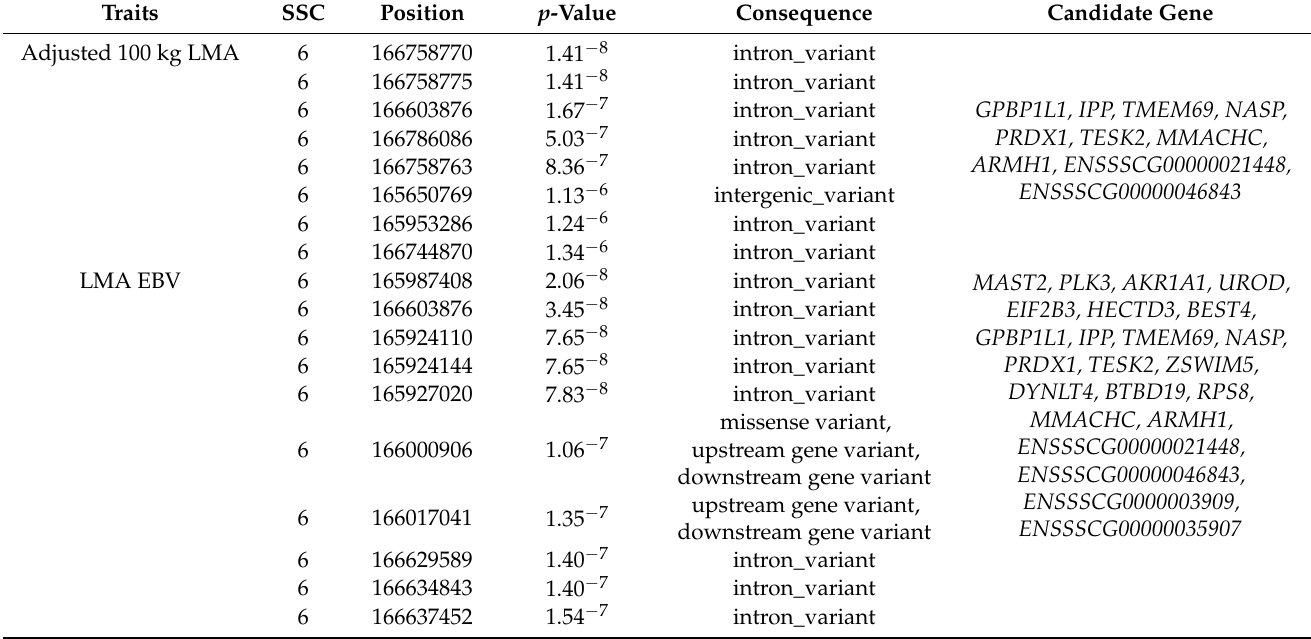
Table 3. Significant SNPs and genes associated with LMA traits in the QTL intervals identified by 2-LOD drop